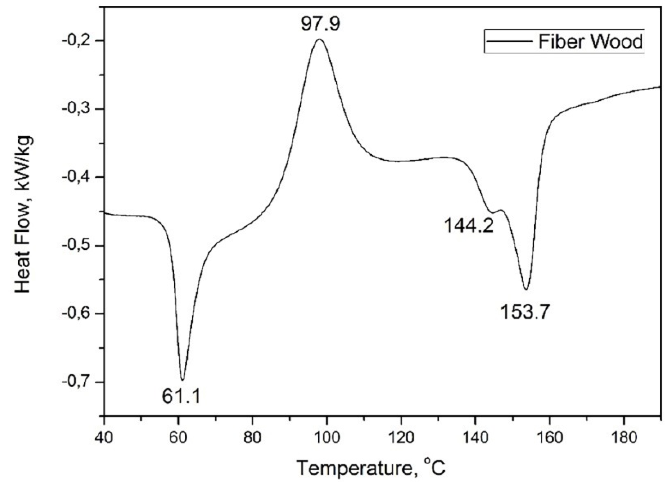
Figure 7. Highlighting the main thermal behavior of the Fiber Wood wire.